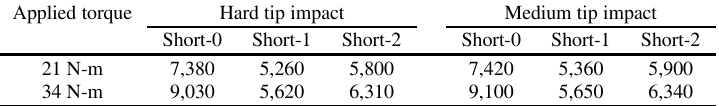
Table 3 Excitation frequencies (Hz) observed in FFT response of experimentally